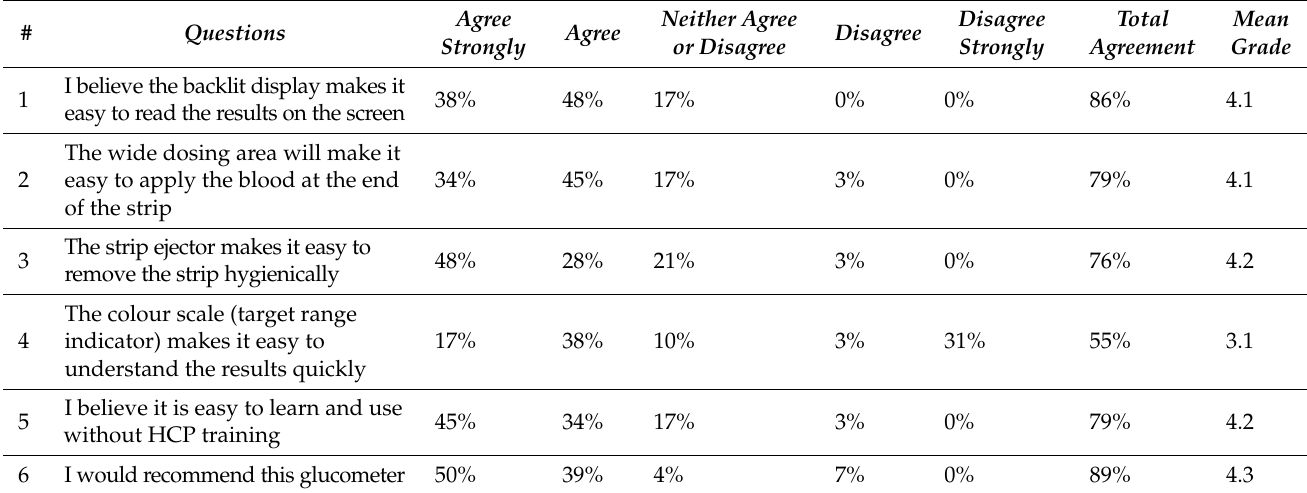
Table 3. Patients’ answers regarding the features of Accu-Chek ® Instant